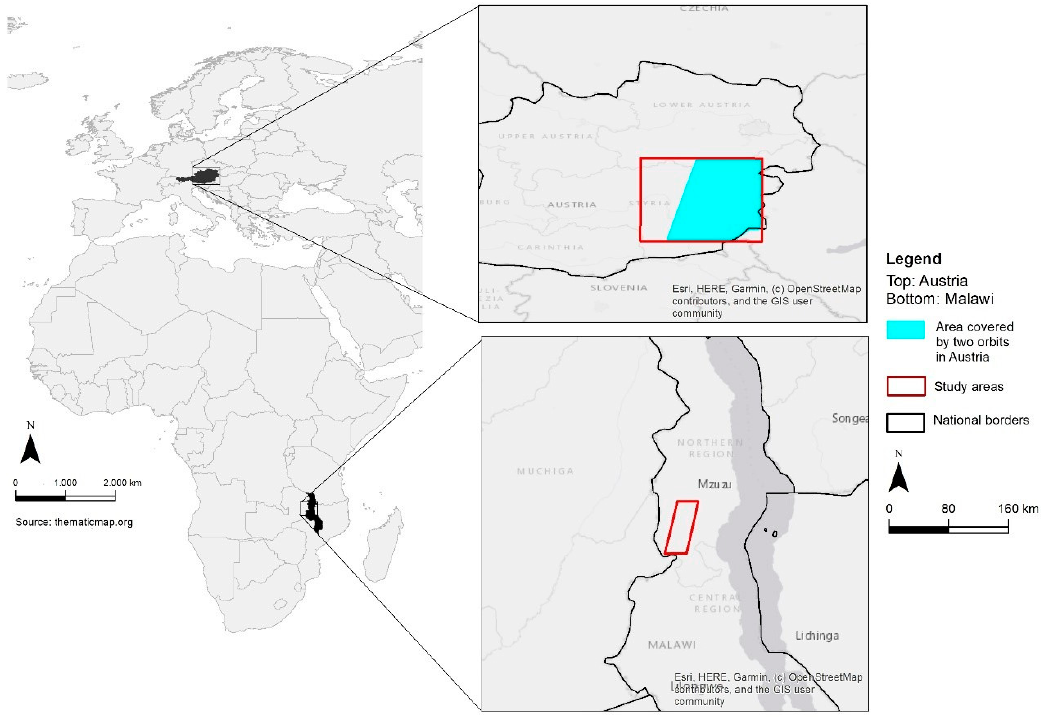
Figure 1. Location of the test sites.